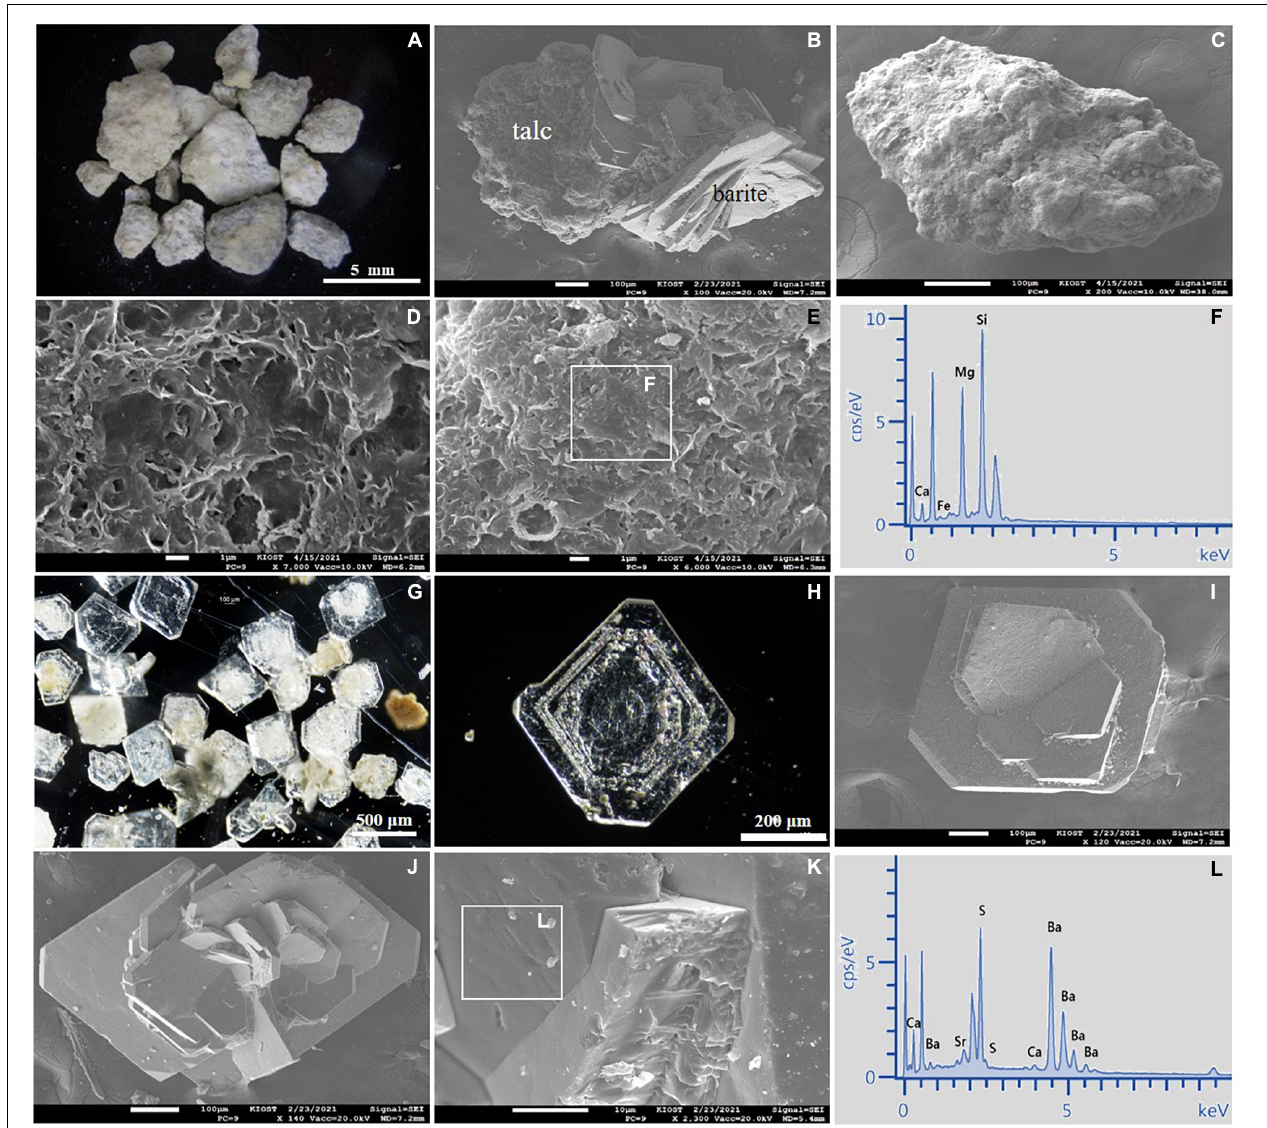
FIGURE 4 | (A) Microscopic photograph and (B–E) SEM-BSI images of talc samples from the OVF surface sediments (BC1903 and GTV1904). (G,H) Microscopic photographs and (I–K) SEM-BSI images of barite samples from the OVF surface sediment (GTV1904). (F,L) EDS analysis of talc and barite sample,